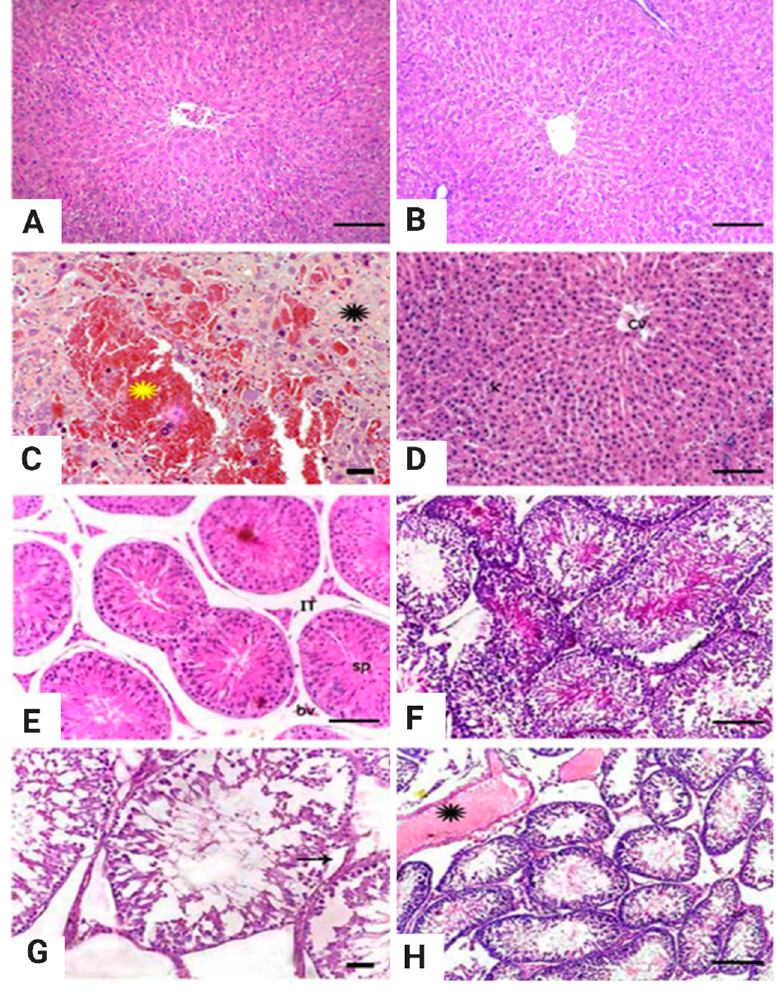
Figure 3. Representative photomicrograph for liver and testes tissues from Westar male albino rats treated with Cyclosporine (CsA) and/or Garlic for four weeks, H&E, scale bar = 200 µ m ( A , B , D ), bar = 100 µ m ( E , F , H ), bar = 50 µ m ( C , G ). ( A , B ) Hepatic tissue of control ( A ) and garlic-treated rats ( B ) showing normal hepatic cords and central vein. (C) Liver tissues from a rat treated with CsA (10 mg/kg BW/day) showing area of hemorrhage (yellow asterisks) and necrotic hepatocytes (black asterisks). ( D ) Liver tissues of the co-treated group with CsA and garlic showing nearly normal hepatic tissue with the central vein. ( E , F ) Testicular tissues from control ( E ) and garlic-treated rats ( F ) showing normal histologic limits of seminiferous tubule lined by stratified germinal epithelium and contains luminal aggregations of sperms, the interstitium (IT) shows clusters of cells and blood vessels. ( G ) Testis from CsA treated rats showing damaged seminiferous tubules, maturation arrest up to the spermatogonia stage, Sertoli cell vacuolization (arrow), and wide intracellular space. ( H ) Testes from rat co-treated with CsA and garlic showing a mild improvement of the seminiferous tubules with some of them showing complete sperm maturation with congested blood vessels